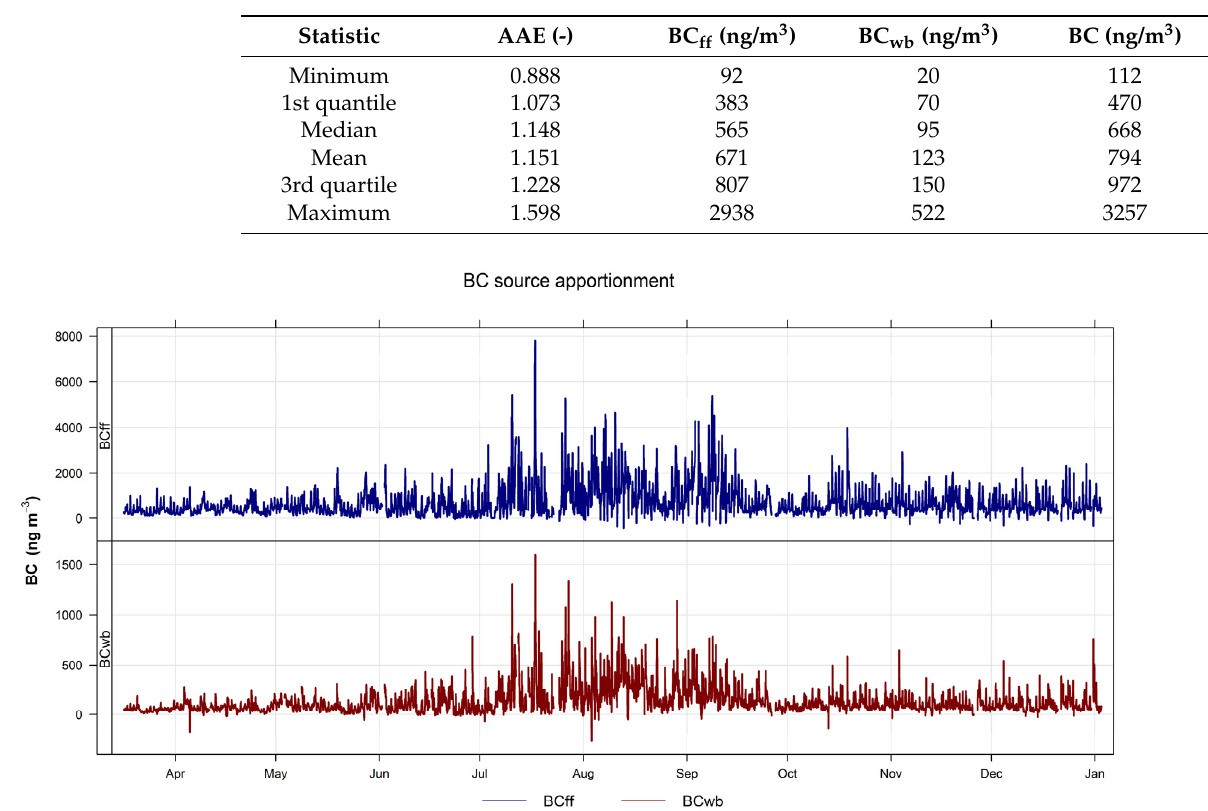
Figure A2. Time plot of hourly BC ff and BC wb concentrations, 2020 campaign.